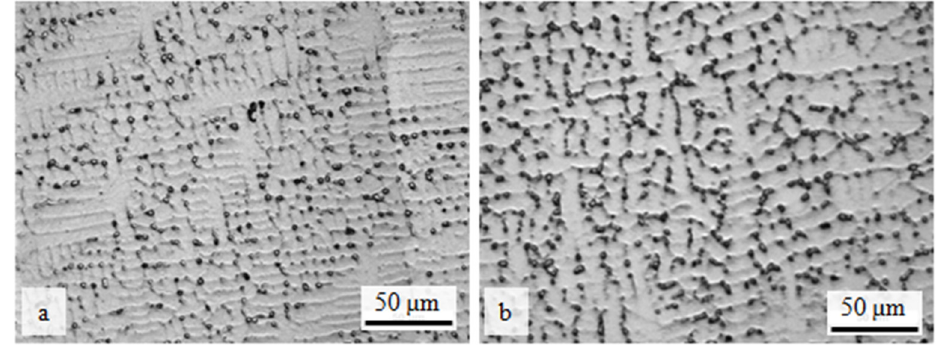
Figure 3. The optical images of the dendritic structure in the as-weld condition in ( a ) Monel K500 and ( b ) FM60 (travel speed of 400 mm/min).